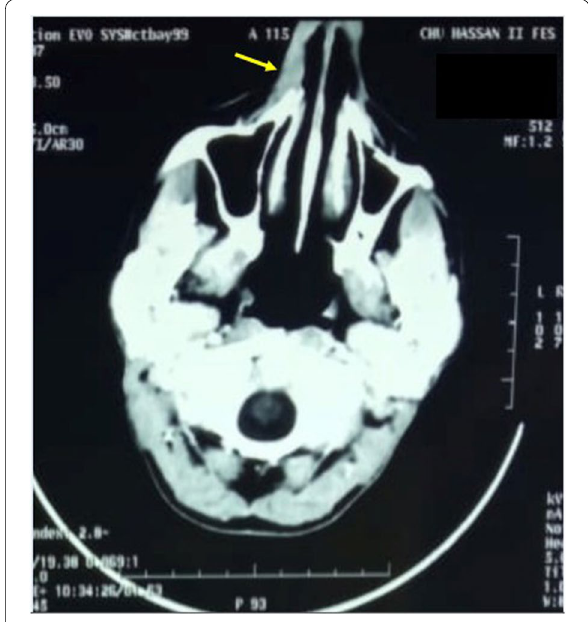
Fig. 3 CT scan axial view with contrast showing subcutaneous